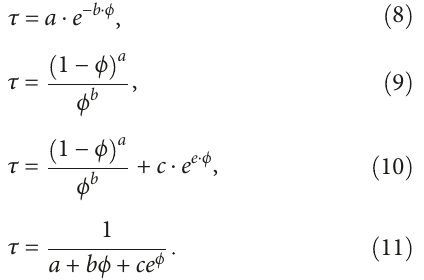
Figure 13. The permeability is normalized against the perme- ability of a channel with the maximum initial fracture width, which is the initial permeability of 20-mesh proppant- supported fracture. The permeability can be a ff ected by the proppant size and the embedment ratio. With an increase